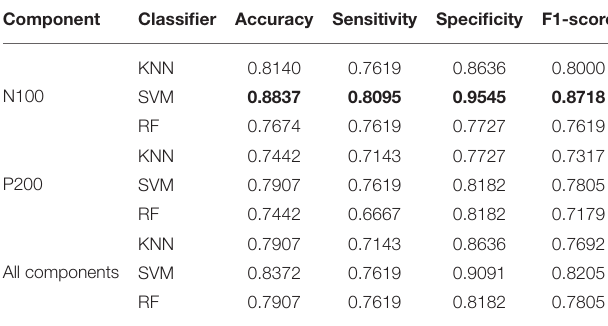
TABLE 2 | Classification results by all classifiers in different